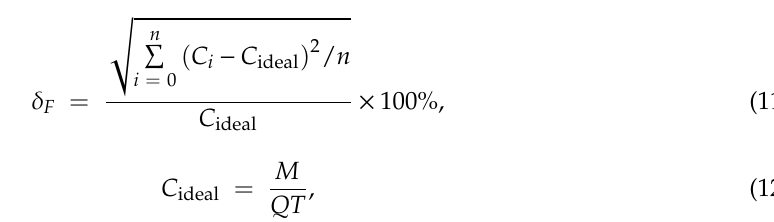
Figure 4. Configuration of the experimental device for evaluating the fertilization uniformity of the designed fertigation device. (unit: mm). 1. DC pump 2. Flowmeter 3. Fertilizer-feeding component 4.